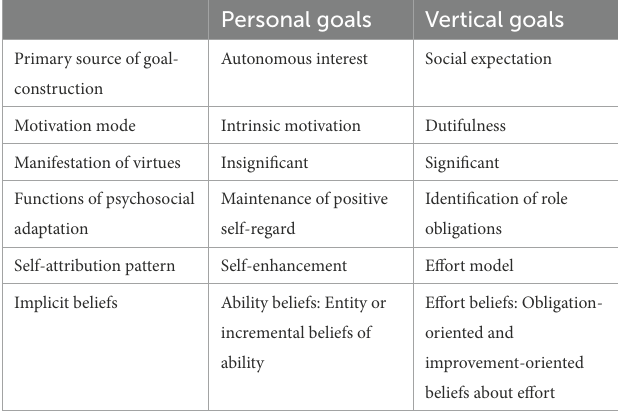
TABLE 1 The dual-mode framework of achievement